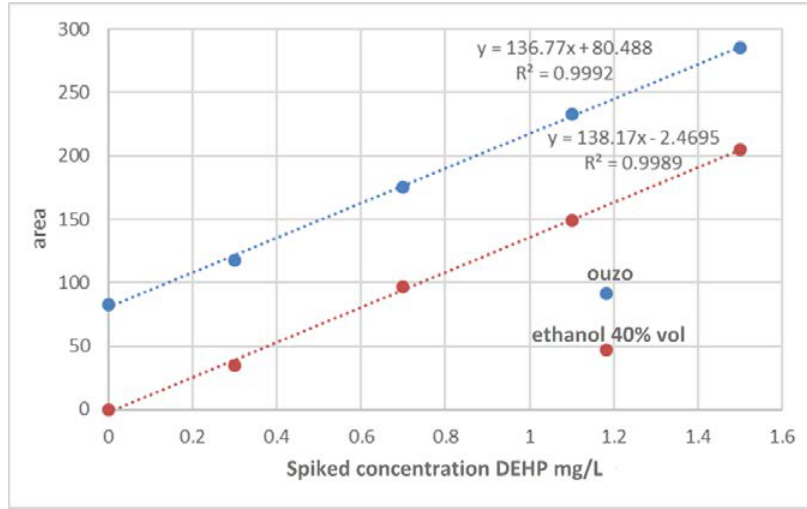
Figure 4. Least-squares curves, for matrix effect check: Ouzo and ethyl alcohol 40% v / v .